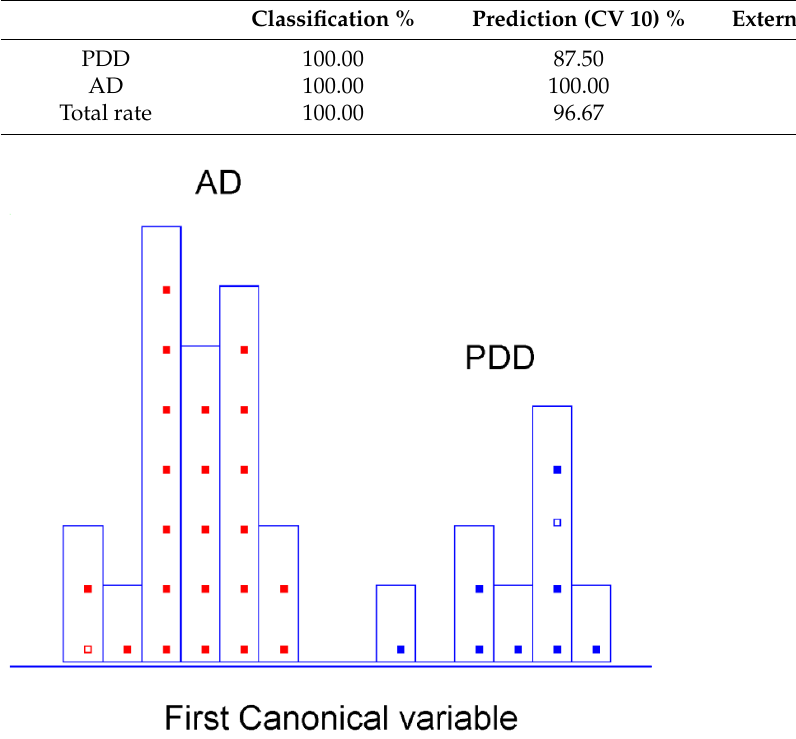
Figure 5. Histogram of canonical variable for the discrimination of PD-related dementia ( (cid:4) ) and Alzheimer’s dementia ( (cid:4) ) patients after performing SELECT-LDA in the PD dementia type direct differentiation approach ( y -axis indicates the maximum discrimination power between categories). Table 6. Percentages of samples/patients classified correctly in both classification and internal/external validation in the SELECT-LDA performed when addressing the classification approach for dementia type differentiation.